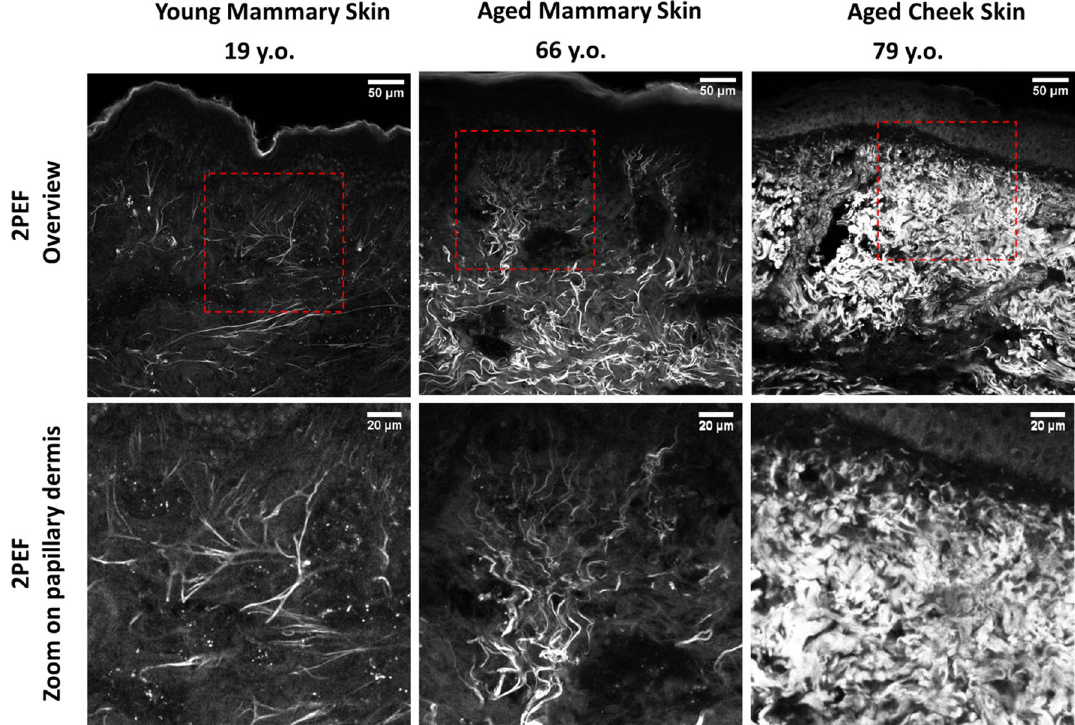
Figure 7. Two-photon-excited fluorescence (2PEF) images revealing elastic fibers, cells, glands in cross-sections of young mammary skin (19 years old), old mammary skin (66 years old) and old cheek skin (79 years old) observed in multiphoton microscopy. Top images are overview and lower images are zoomed on the papillary area.